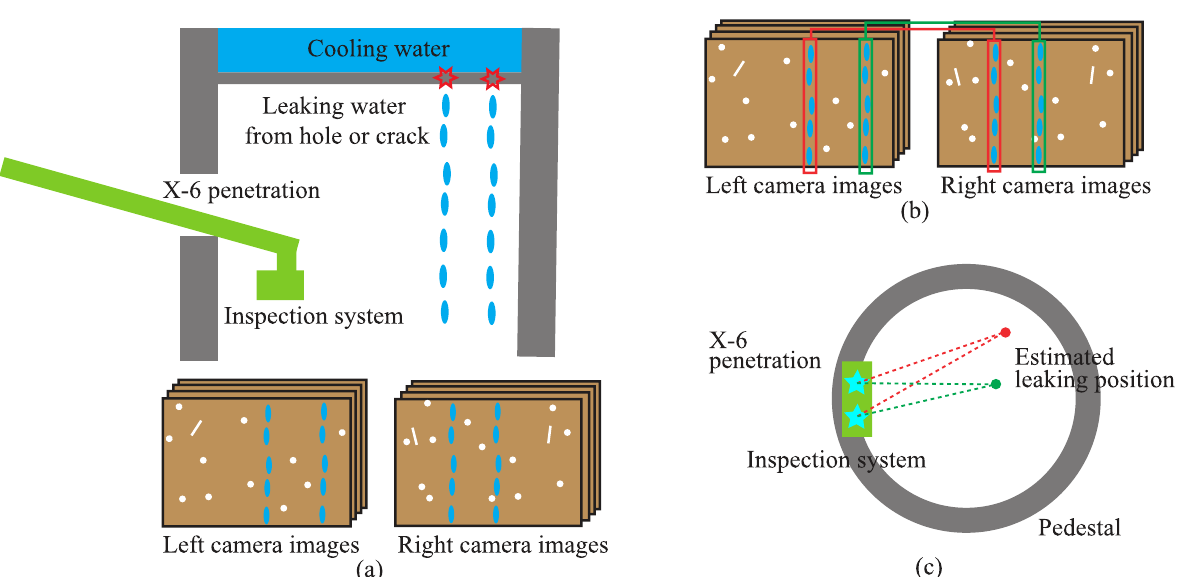
Figure 2. Overview of the proposed method. ( a ) Capturing waterdrops for a few seconds using a stereo camera in the pedestal. Blue eclipses represent waterdrops, and white circles and lines represent the radiation noise in the stereo images. ( b ) Waterdrop trajectory detection and matching. The red and green rectangles represent the corresponding trajectories. ( c ) Estimation of the leakage position by triangulating the corresponding trajectory lines. The concept of the triangulation is illustrated as dot lines, and the cyan stars on the inspection system represent the stereo cameras. This figure illustrates a top view of the